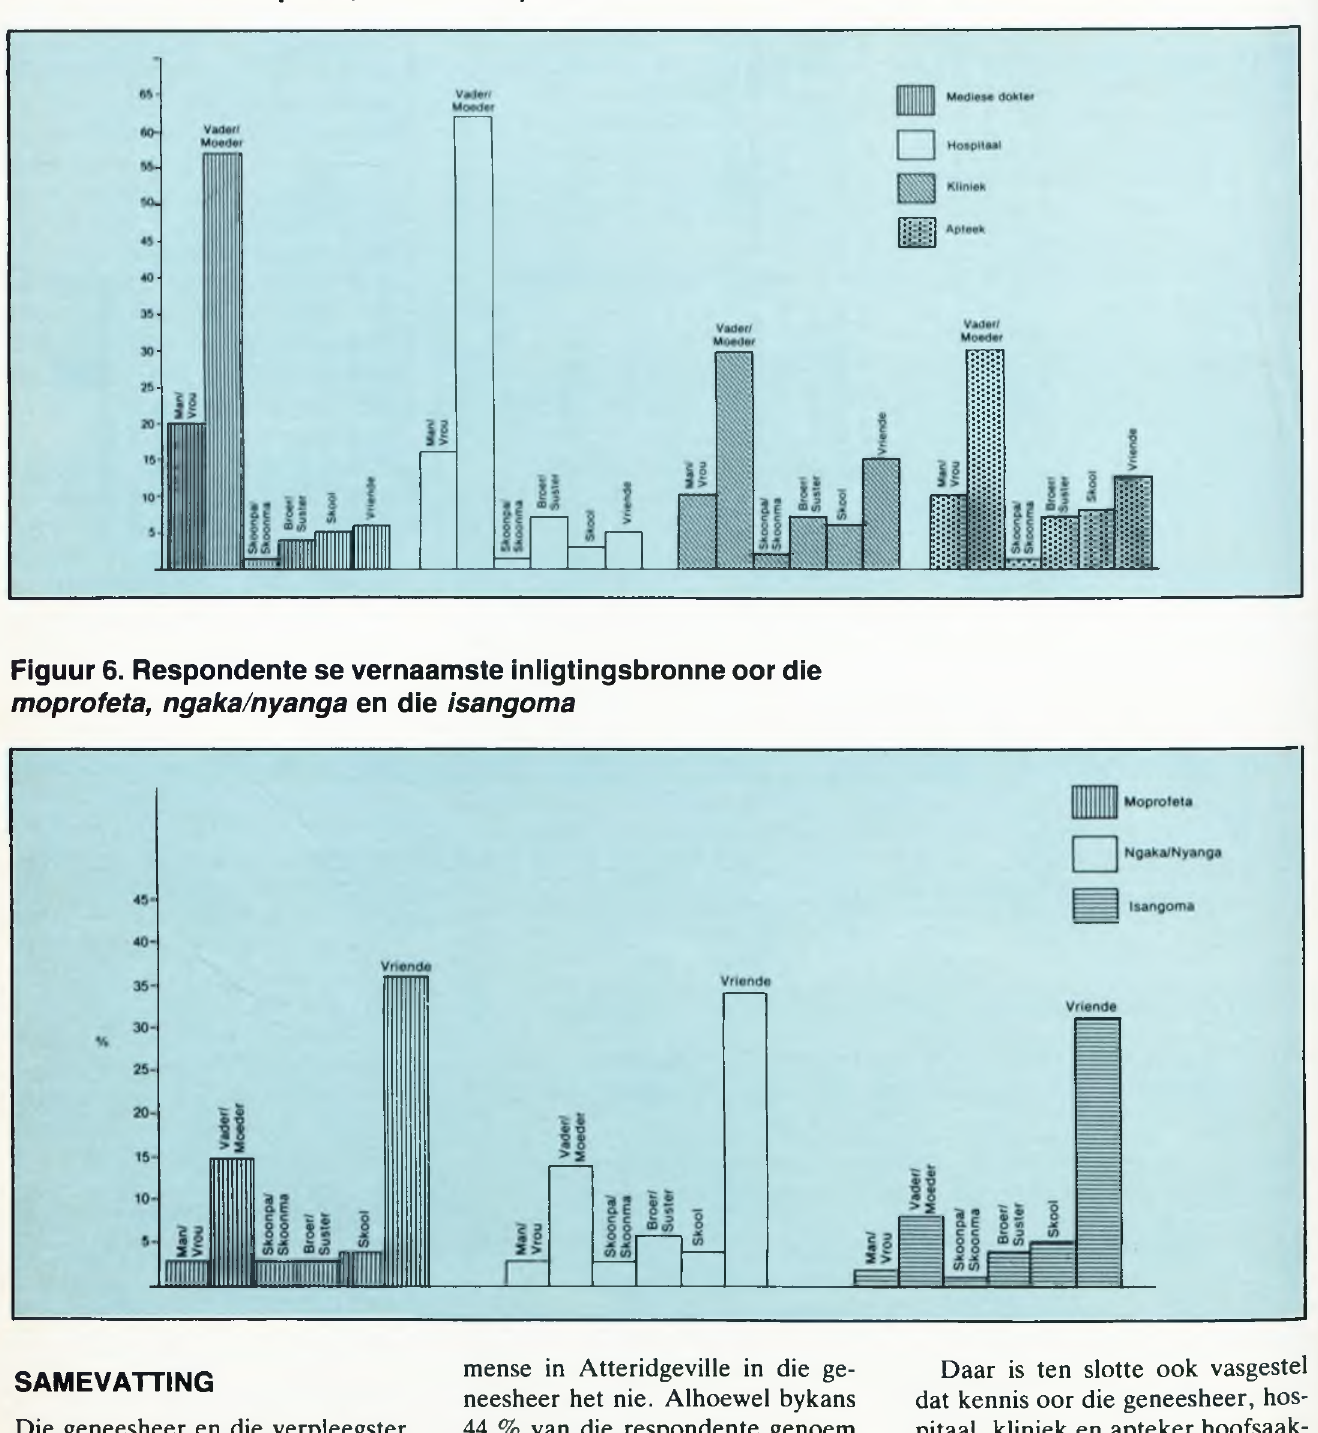
Figuur 5. Respondente se vernaamste inligtingsbronne oor die mediese dokter: hospitaal, kliniek en apteek